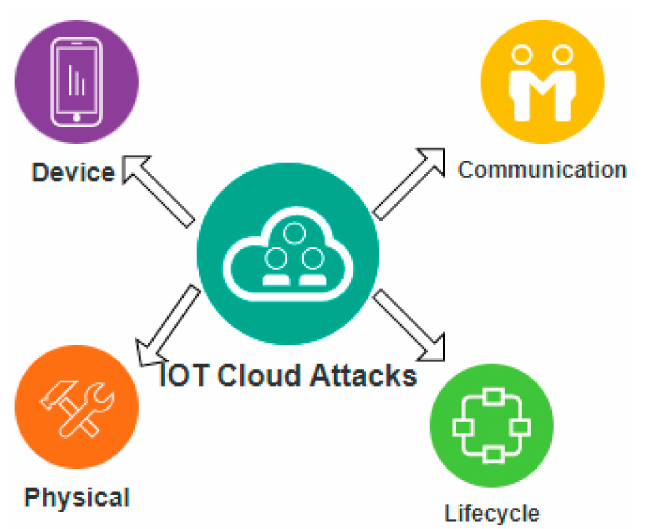
Figure 1. IoT Attack